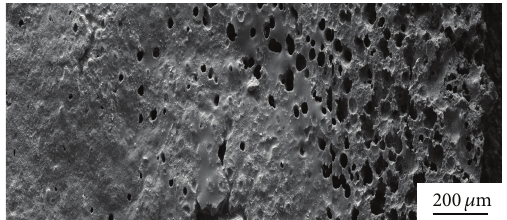
Figure 7: Surface micrographs of ZSB materials after thermal shock for 30 times at 1800 ∘